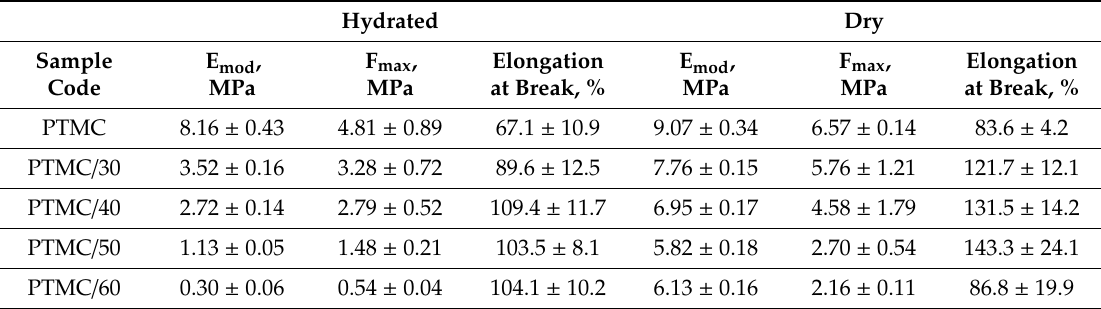
Table 4. Mechanical properties of PTMC and microporous PTMC films in hydrated and dry